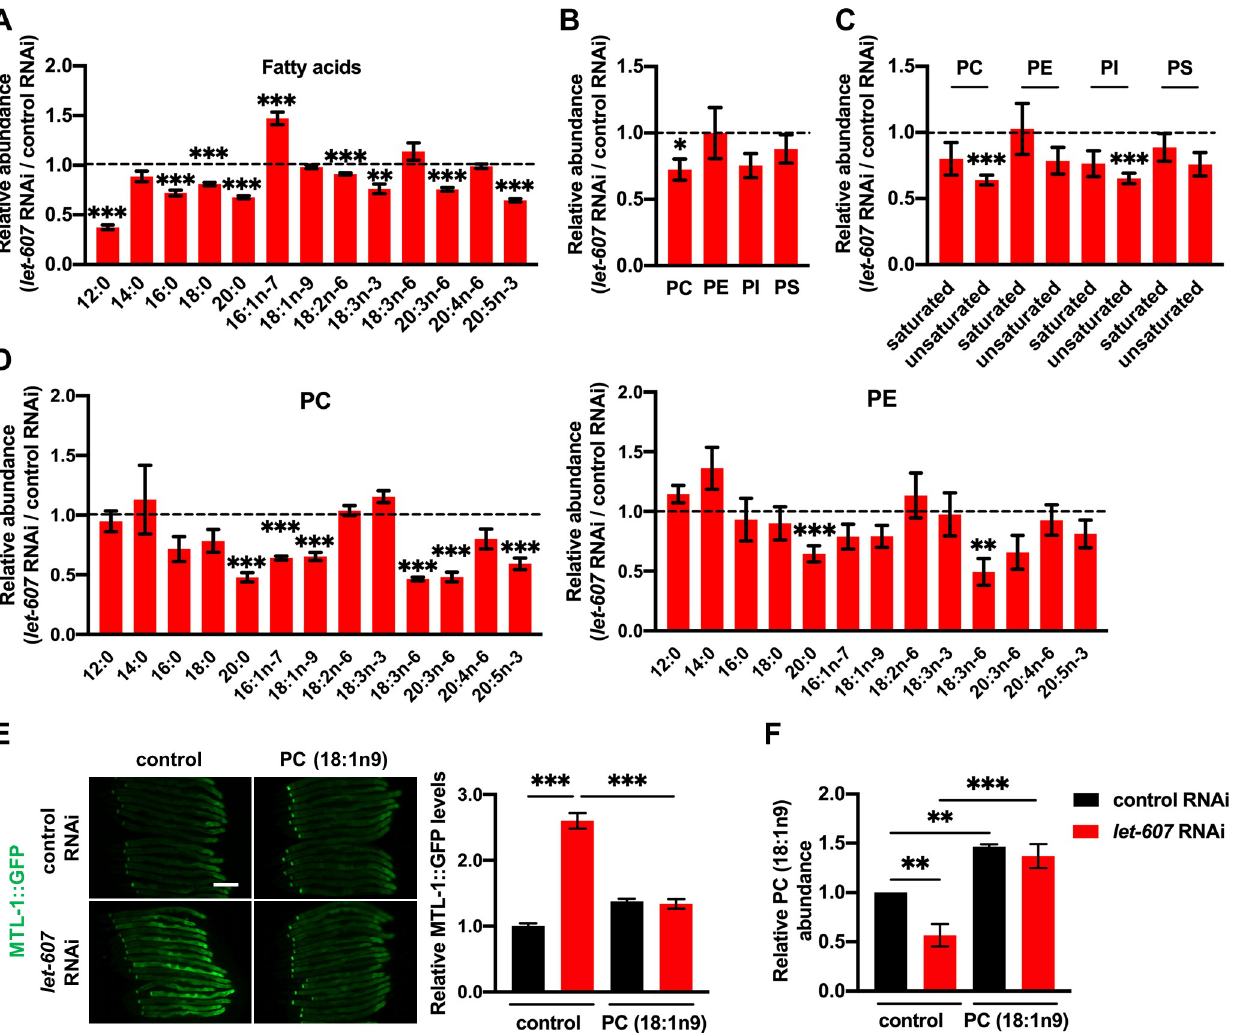
Fig 5. LET-607 regulates PC metabolism. (A) Effects of let-607 RNAi on fatty acid contents. (B) Effects of let-607 RNAi on the abundance of membrane lipids. (C) Effects of let-607 RNAi on the abundance of saturated and unsaturated fatty acids in the PC, PE, PI and PS fractions. (D) Fatty acid contents in the PC and PE fractions after let-607 RNAi. (E) MTL-1::GFP expression in let-607 knockdown animals after PC supplementation. Left panel, representative images. Right panel: quantification data. Scale bar = 100 μ m. (F) PC (18:1n9) contents after PC (18:1n9) supplementation. For (A) and (F), n = 3 per group; for (B-D), n = 5 per group. Data were presented as mean ± SEM. � p < 0.05, �� p < 0.01, ��� <